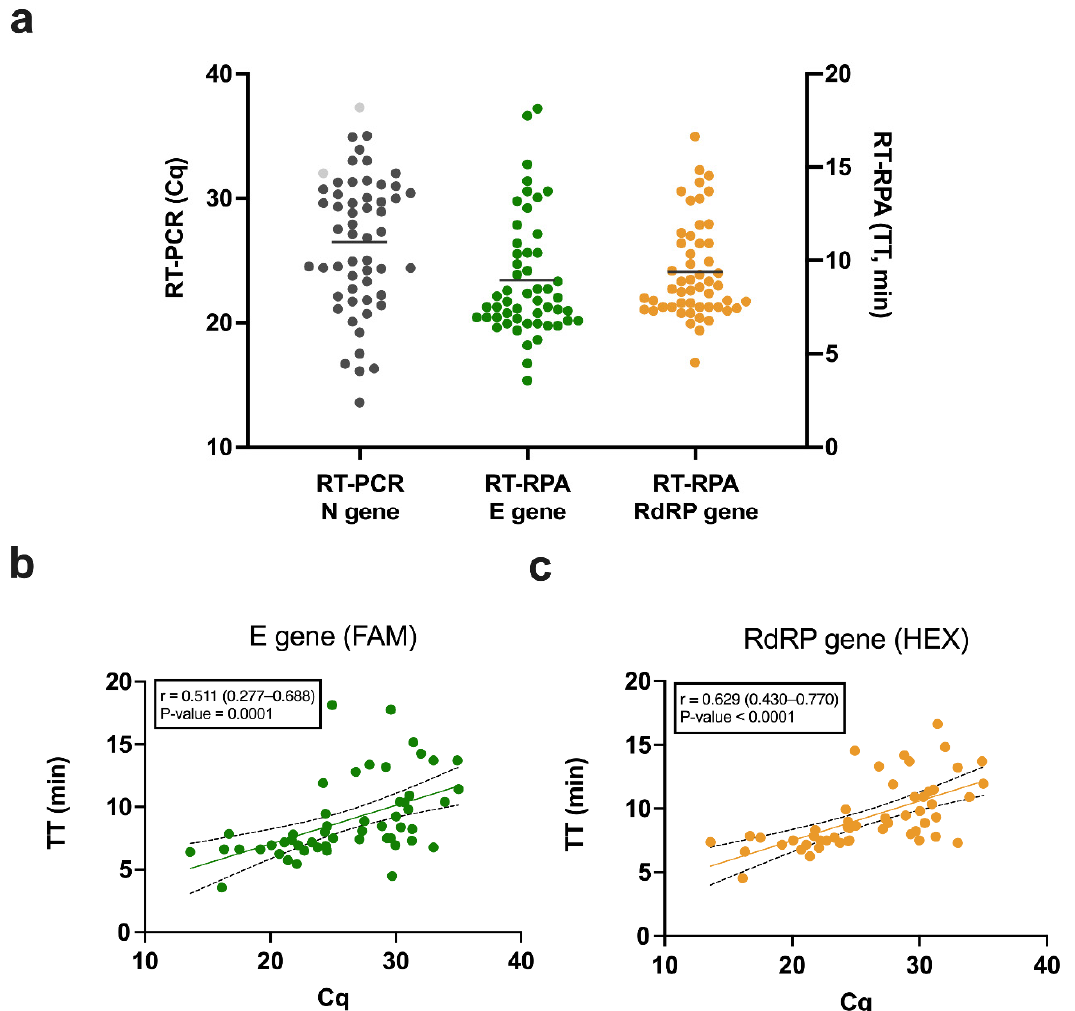
Figure 3. Correlation between quantification cycle (Cq) values from RT-PCR and time to threshold (TT) from RT-RPA. ( a ) Comparison of Cq from RT-PCR and TT from RT-RPA for all positive samples. Dark grey dots represent the true positive samples and light grey dots represent the false negative samples. The horizontal lines represent the mean Cq for RT-PCR and the mean TT for RT-RPA. ( b ) Linear regression between Cq values (RT-PCR N gene) and TT values (RT-RPA E gene) with the associated Pearson correlation coefficient r (95% CI) and p -value. The dashed lines represent the 95% confidence interval. The green dots represent the clinical samples detected by the RT-RPA E gene target. ( c ) Linear regression between Cq values (RT-PCR N gene) and TT values (RT-RPA RdRP gene) with the associated Pearson correlation coefficient r (95% CI) and p -value. The dashed lines represent the 95% confidence interval. The yellow dots represent the clinical samples detected by the RT-RPA RdRP gene target.